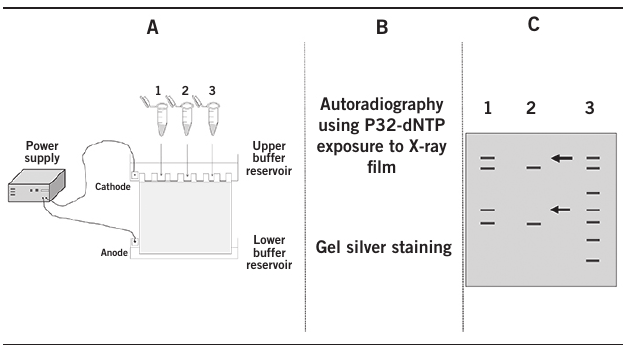
figurE 2 − Manual reading of LOH screening using denaturing PAGE LOH: loss of heterozygosity; PAGE: polyacrylamide gel electrophoresis; PCR: polymerase chain reaction; DNA: deoxyribonucleic